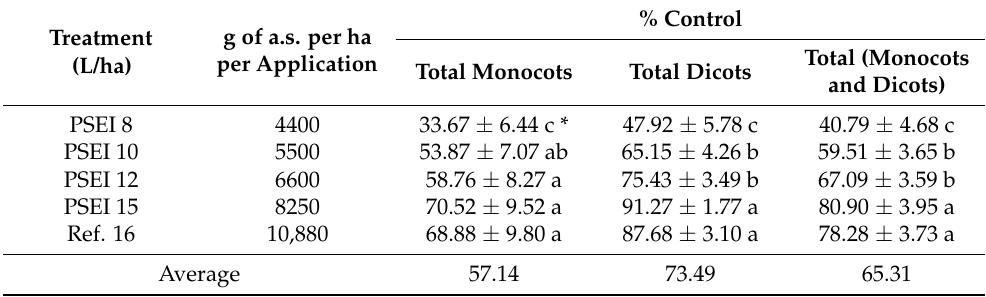
Table 8. Effects of PA formulation and commercial reference PA-based herbicide on monocots, dicots, and total weeds 14 days after second application. Data are expressed as percentage of weed control compared to untreated treatment ± standard error (seven trials with four replicates, n =